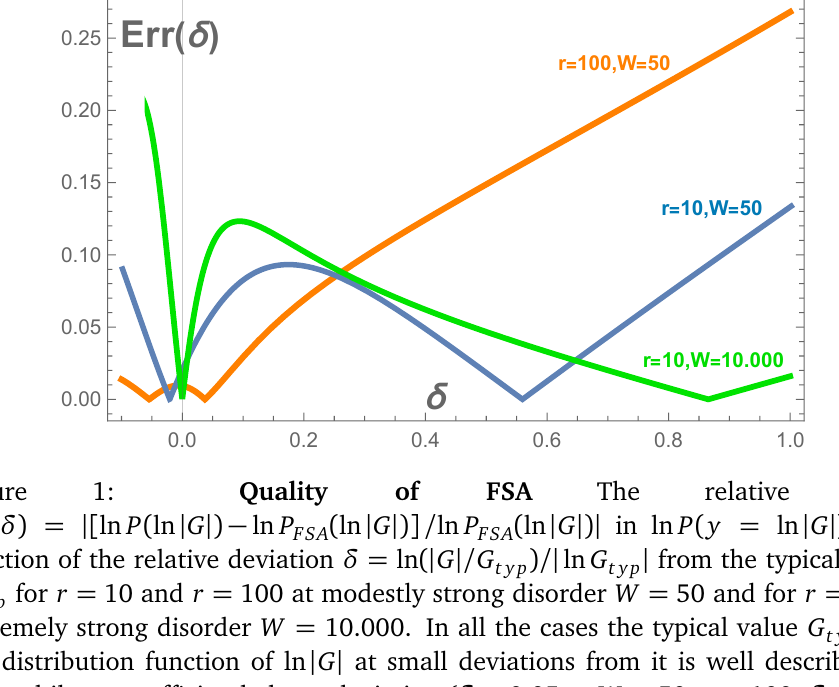
Figure 1: Quality of FSA The relative error ( ln | G | )] / ln P ( ln | G | ) | in ln P ( y = ln | G | ) as a Err ( δ ) = | [ ln P ( ln | G | ) − ln P FSA FSA ) / | ln G | from the typical value function of the relative deviation δ = ln ( | G | / G t yp t yp G for r = 10 and r = 100 at modestly strong disorder W = 50 and for r = 10 at t yp extremely strong disorder W = 10.000. In all the cases the typical value G and t yp the distribution function of ln | G | at small deviations from it is well described by FSA, while at a sufficiently large deviation ( δ > 0.05 at W = 50, r = 100; δ > 0.55 at W = 50 and r = 10; δ > 0.85 at W = 10.000, r = 10 ) the error changes the sign (resulting in a cusp on a plot of its absolute value) and increases indefinitely as the deviation further grows. Extremely large disorder may delay the onset and reduce the slope of this growth but it does not suppress the error completely. At ( E ) the overestimation of a large distance r between the points i and j in G ij ij ln P ( y = ln | G | ) by FSA at large | G | > G is greatly t yp